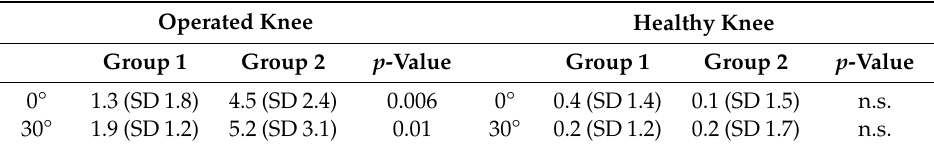
Table 3. Di ff erence (in mm) between the pre- and post-operative measurements with regard to the lateral knee compartment gapping in varus-stress radiographs with both knees (operated and healthy) at full extension and 30 ◦ of flexion. Not significant (n.s.)